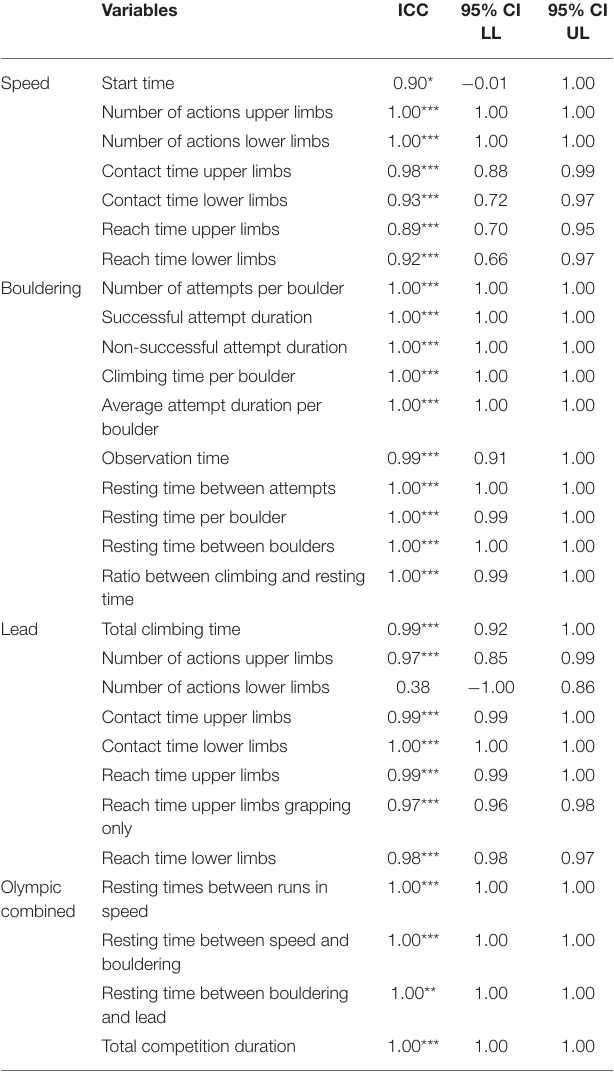
TABLE 1 | Inter-rater reliability of the analyzed dependent variables used for load structure determination.